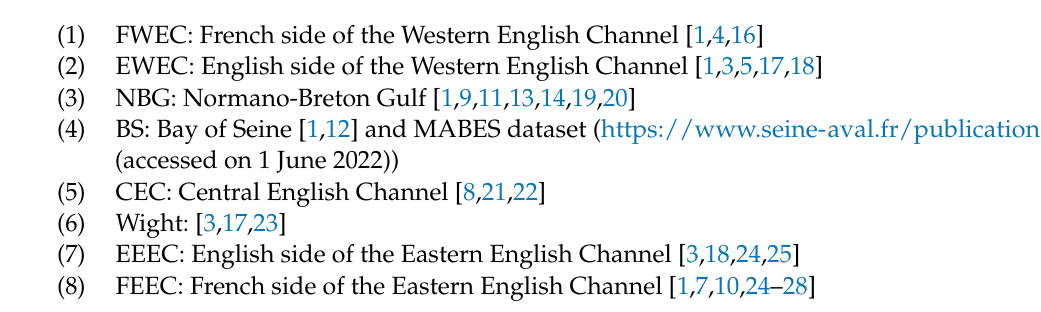
Table 2. Checklist of amphipods in the English Channel. NIS: Non-Indigenous Species. FWEC: